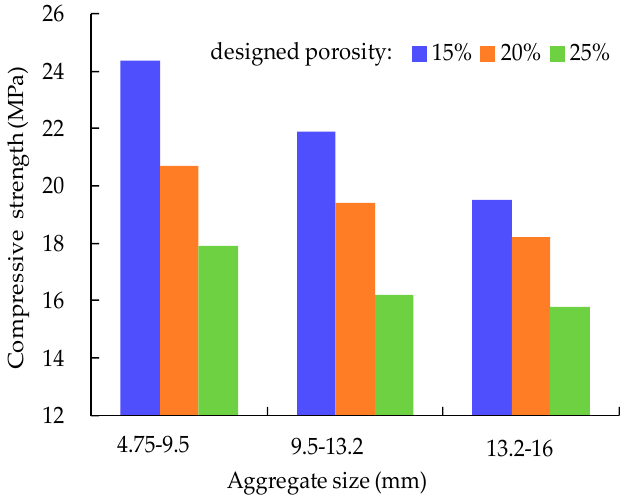
Figure 10. Relationship between compressive strength, designed porosity, and aggregate size.